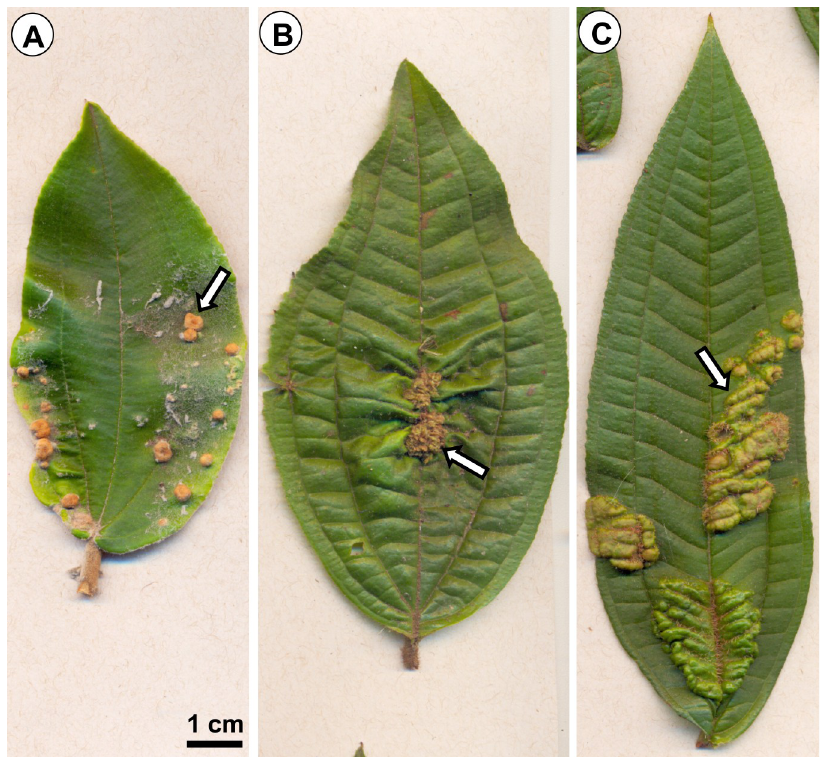
Fig 1. Galls studied. (A) Gall (arrow) induced by Ditylenchus gallaeformans (Nematoda) on a Miconia albicans (Melastomataceae) leaf. (B) Gall (arrow) induced by D . gallaeformans on a M . ibaguensis leaf. (C) Gall (arrow) induced by an Eriophyidae on a M . ibaguensis